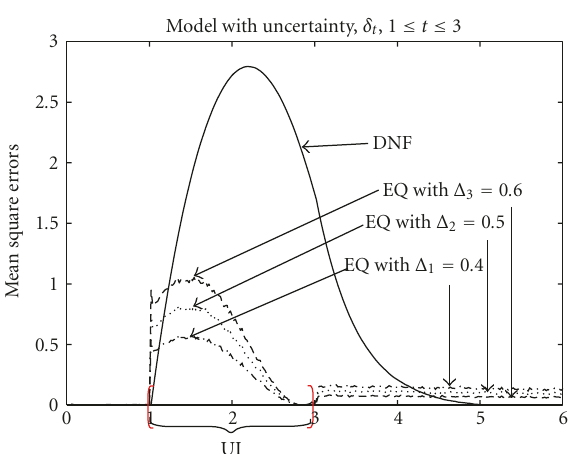
Model with uncertainty, δ t , 1 ≤ t ≤ 3